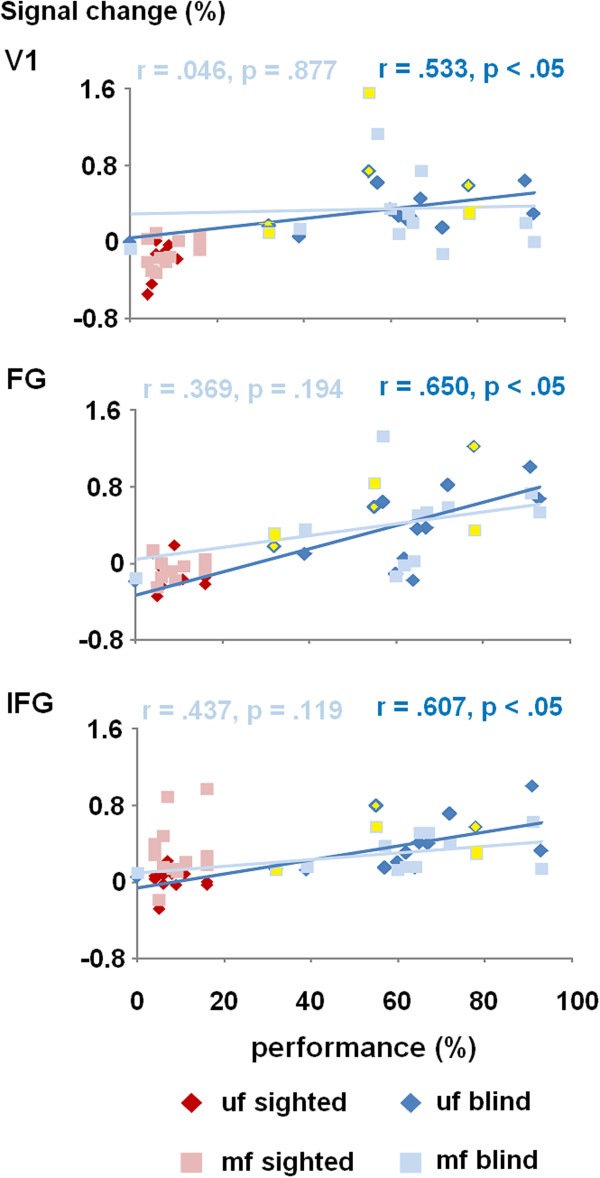
Region-of-interest (ROI) analyses. Percent signal change during the ultra-fast and moderately fast listening conditions plotted against individual behavioral performance during application of ultra-fast test materials – as determined prior to scanning – within three selected ROIs, i.e., right-hemispheric primary visual cortex (V1), left-hemispheric fusiform gyrus (FG), and ipsilateral inferior frontal gyrus (IFG). (Note, because of “ceiling effects”, the behavioral data bound to moderately fast utterances have not been included). Regression lines, correlation coefficients, and significance levels refer to the performance of the blind group during ultra-fast (dark blue lines or values, respectively) and moderately fast conditions (light blue; for further data see Additional file 13). As concerns the blind group, the three early-blind subjects are indicated by an extra-label (yellow values).